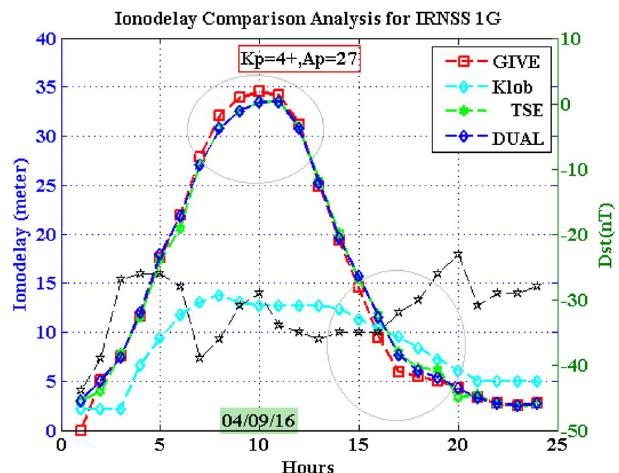
Fig. 13. TSE based ionodelay estimation for NavIC/IRNSS satellites.